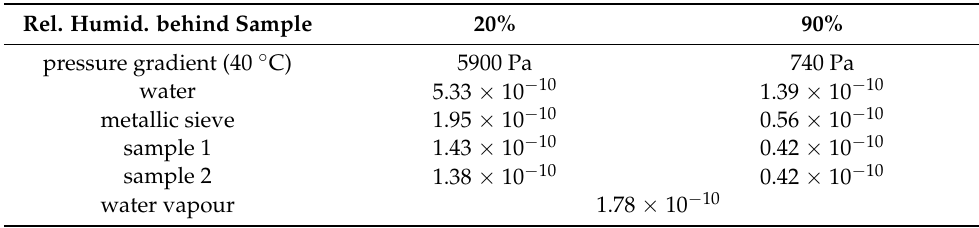
Table 3. Calculated diffusion coefficients (s). Rel. Humid. behind